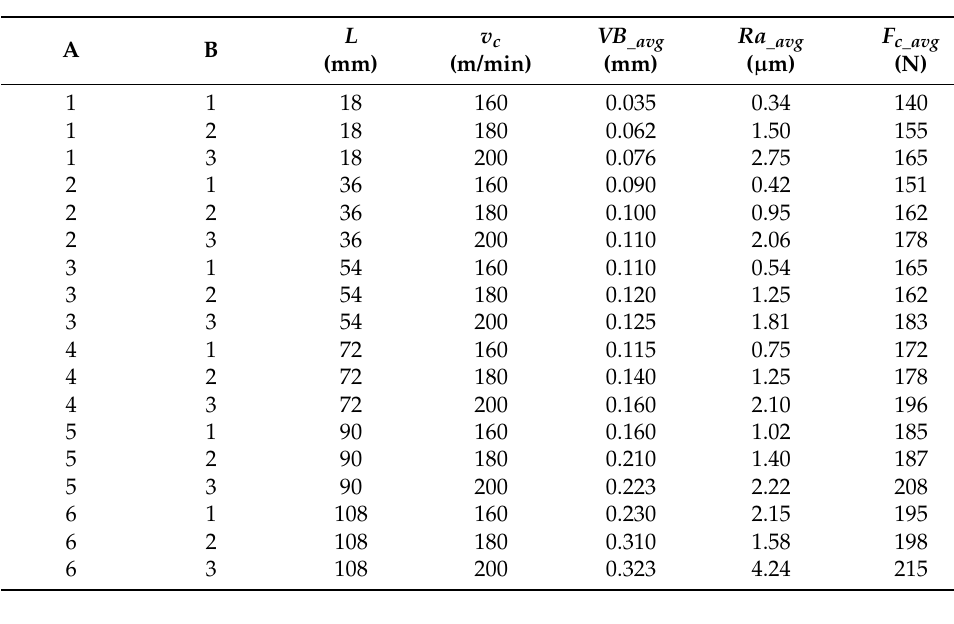
Table 8. The layout of the research plan with the mean values of the analyzed variables.